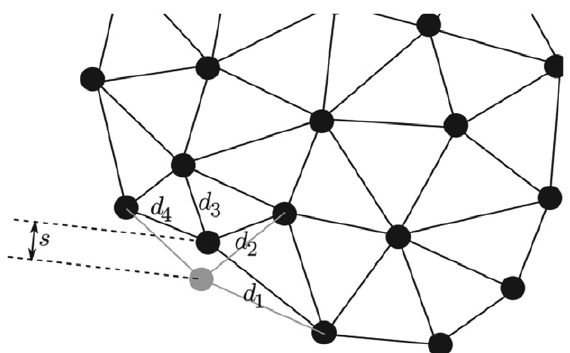
Figure 2: Schematic figure of the triangulated membrane surface in our MC model of the RBC membrane. The links between vertices are bonds, forming triangulated mesh. Lengths of all bonds must satisfy the bond length constraint so that the bond lengths are al- ways in the range between d min and d max . The grayed out vertex is displaced by step size s to a new position. After the move, the lengths of bonds d 1 , d 2 , d 3 and d 4 are calculated and it is verified that they are between d min and d max